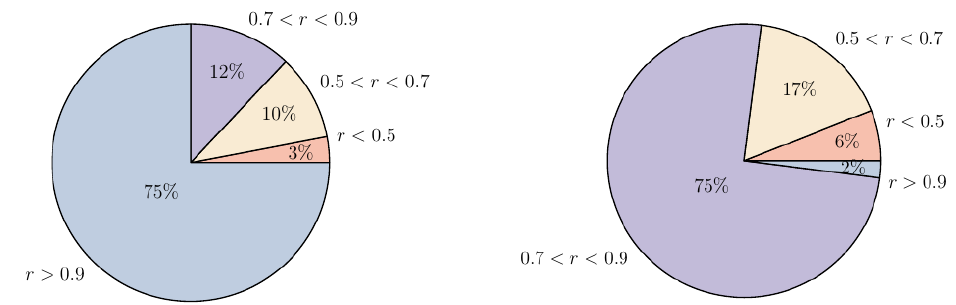
Figure 10. Pearson’s correlation coefficient among irradiance and output power (on the left ) and among temperature and output power (on the right ) obtained in the time frame of 33